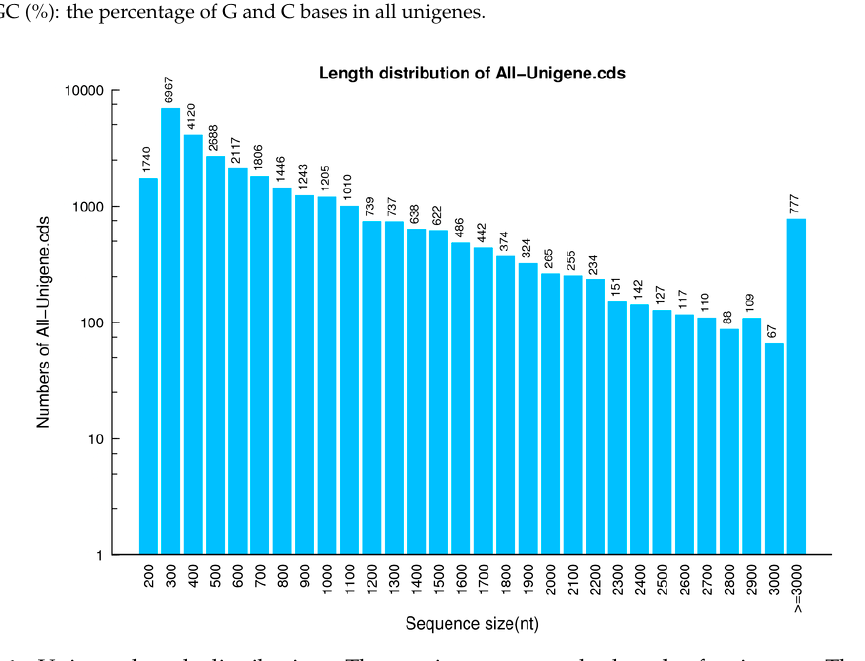
Table 3. Quality metrics of unigenes.